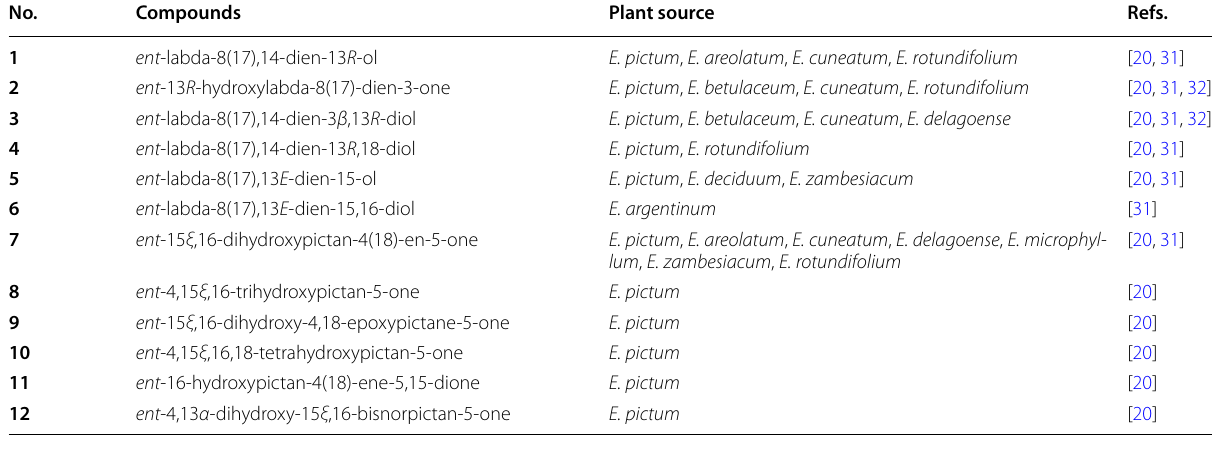
Table 2 Bicyclic diterpenes isolated from Erythroxylum plants No. Plant source Refs.